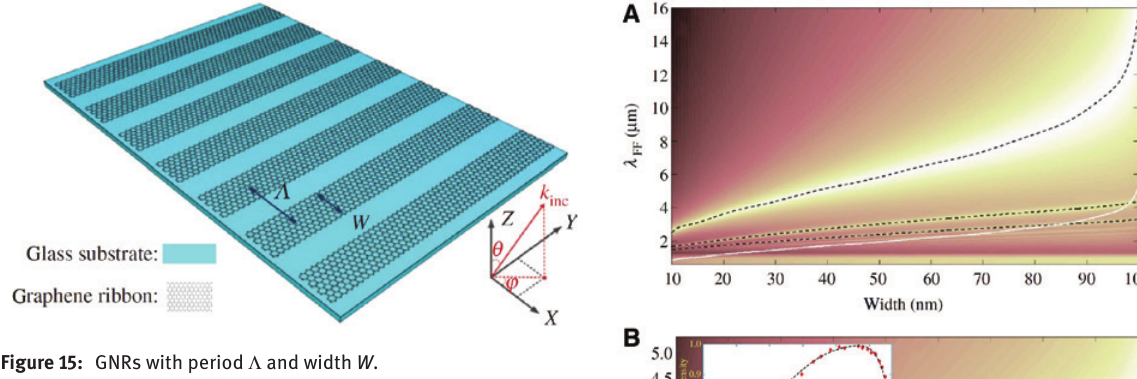
Figure 15: GNRs with period Λ and width W . Reproduced from Ref. [58].